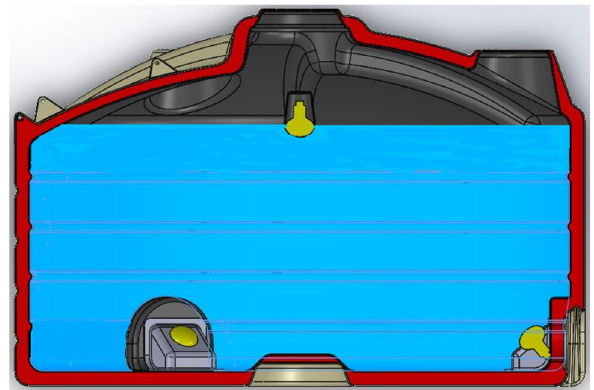
Fig. 11 View of a cut of the vertical tank profile showing its interior indicating the water level